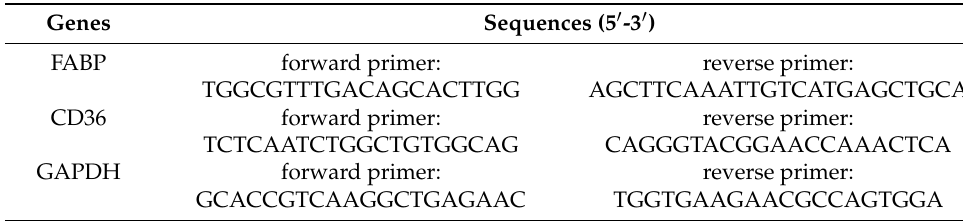
Table 3. Primers sequences used for